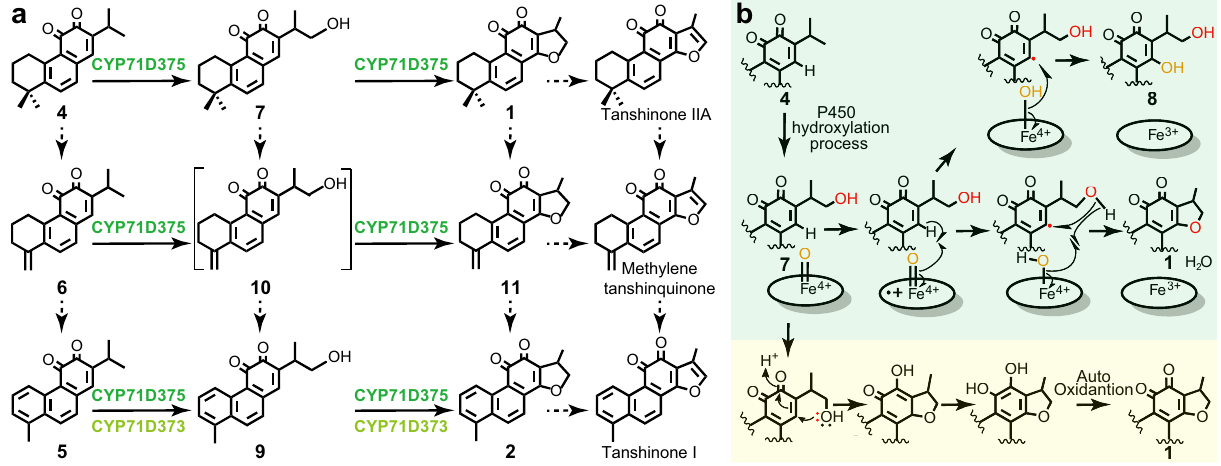
Fig. 6 Catalytic process analysis of CYP71D373 and CYP71D375. a Role of CYP71D373 and CYP71D375 in forming the characteristic tanshinone D-ring heterocycle in a metabolic grid for tanshinone biosynthesis in Danshen. b Proposed reaction mechanisms for heterocyclization of 4 to 1